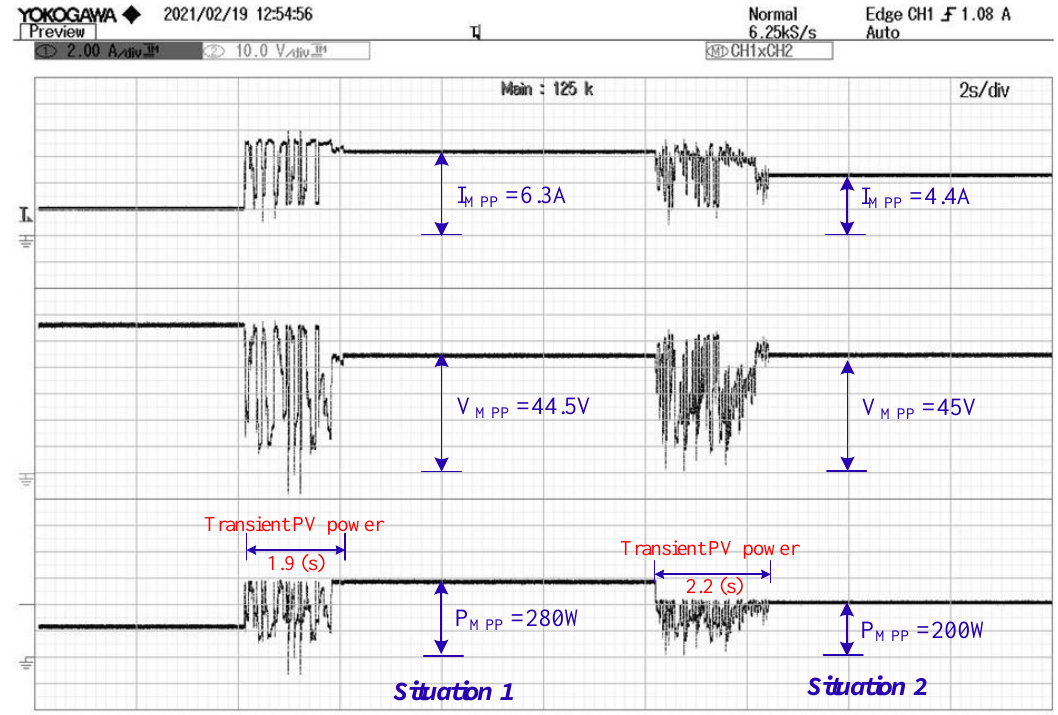
Figure 14. Experimental results of the PSO method (top to bottom: PV current, PV voltage, PV power).